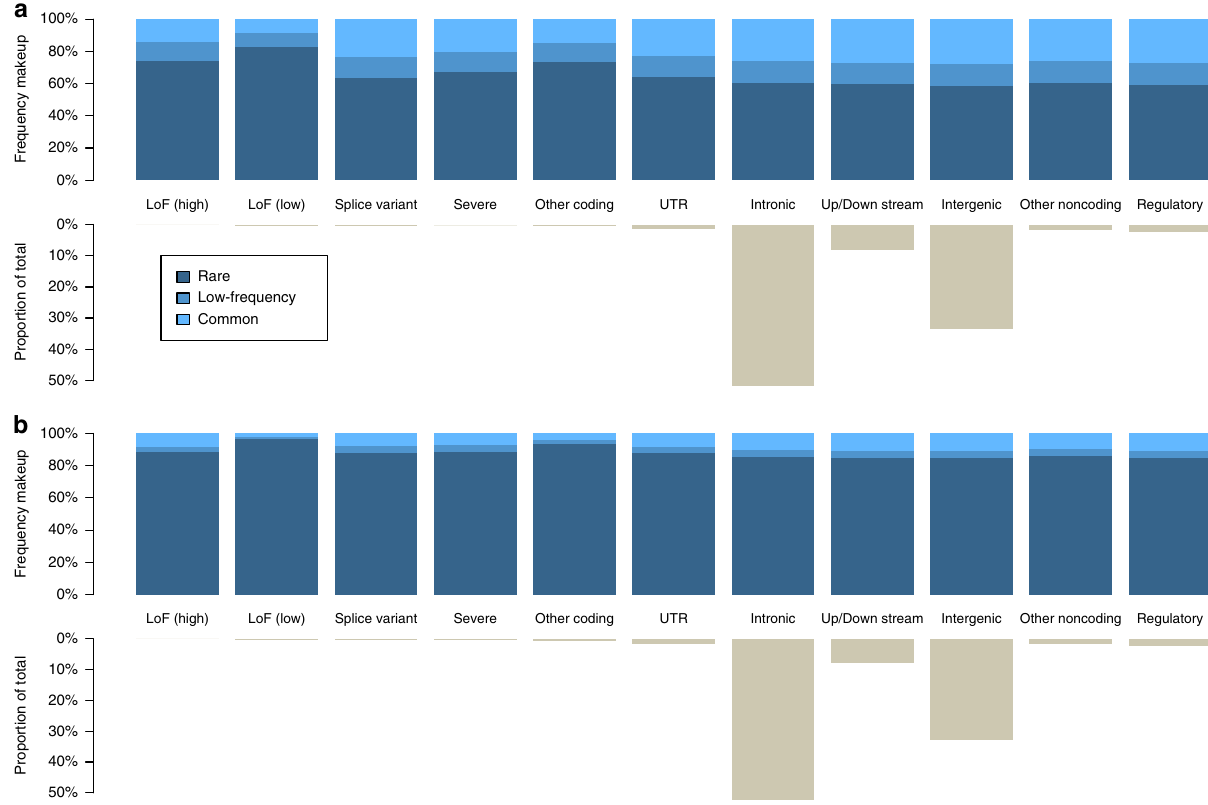
Fig. 2 Variant count proportions and minor allele frequency bin by functional class. a , b Data is shown for MANOLIS ( a ) and INTERVAL ( b ). Functional classes are derived from the Ensembl VEP consequences as detailed in Supplementary Table 6. The number of intergenic variants is likely to be an underestimate due to Ensembl ’ s most severe consequence annotation. For each panel, the bottom half represents the proportion of variants in each class relative to the total number of variants, the upper half represents the frequency makeup of variants in each